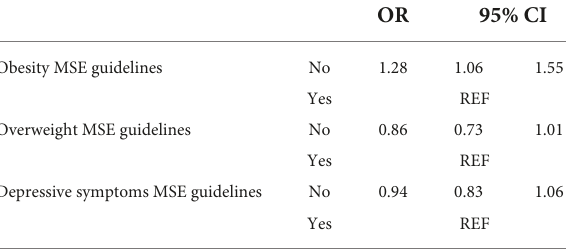
TABLE 2 Association between muscle strength exercise (MSE) guidelines and obesity, overweight, and depressive symptoms.